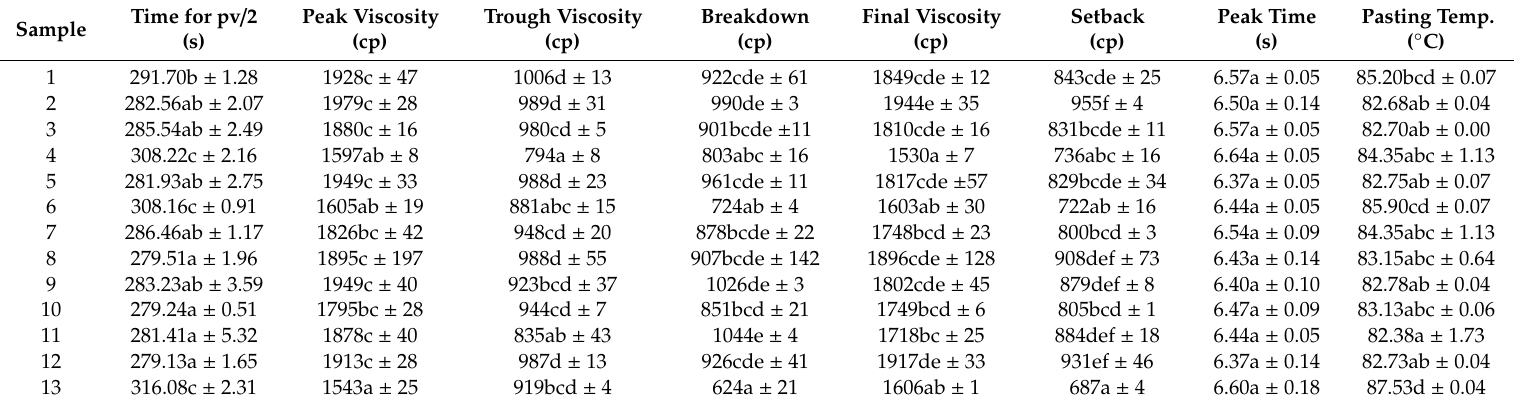
Table 4. RVA parameters of 13 bean flours obtained using brine with a pressurized system reaching 130 ◦